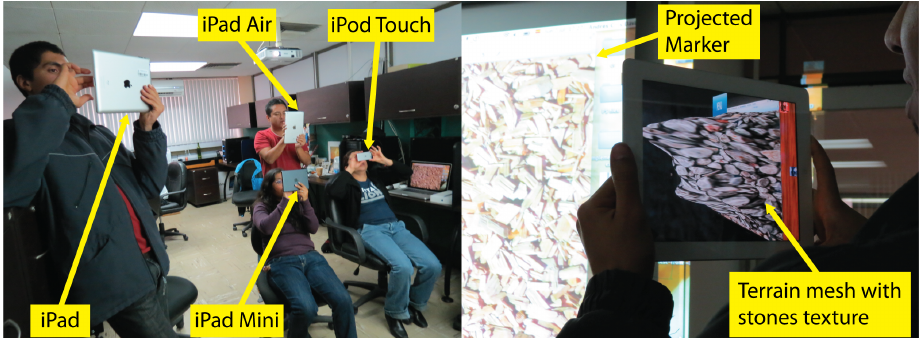
Figure 3. Some participants using the AR mode of our application while the marker is being projected on a wall. The characteristics of the mobile devices are: (1) iPad 3rd generation. Screen size: 9.7 inches. Weight: 660 g, (2) iPad Air 1st generation. Screen size: 9.7 inches. Weight: 469 g, (3) iPad Mini 1st generation. Screen size: 7.9 inches. Weight: 308 g and (4) iPod Touch 5th generation. Screen size: 4 inches. Weight: 88 g. In all devices the camera is 5.0